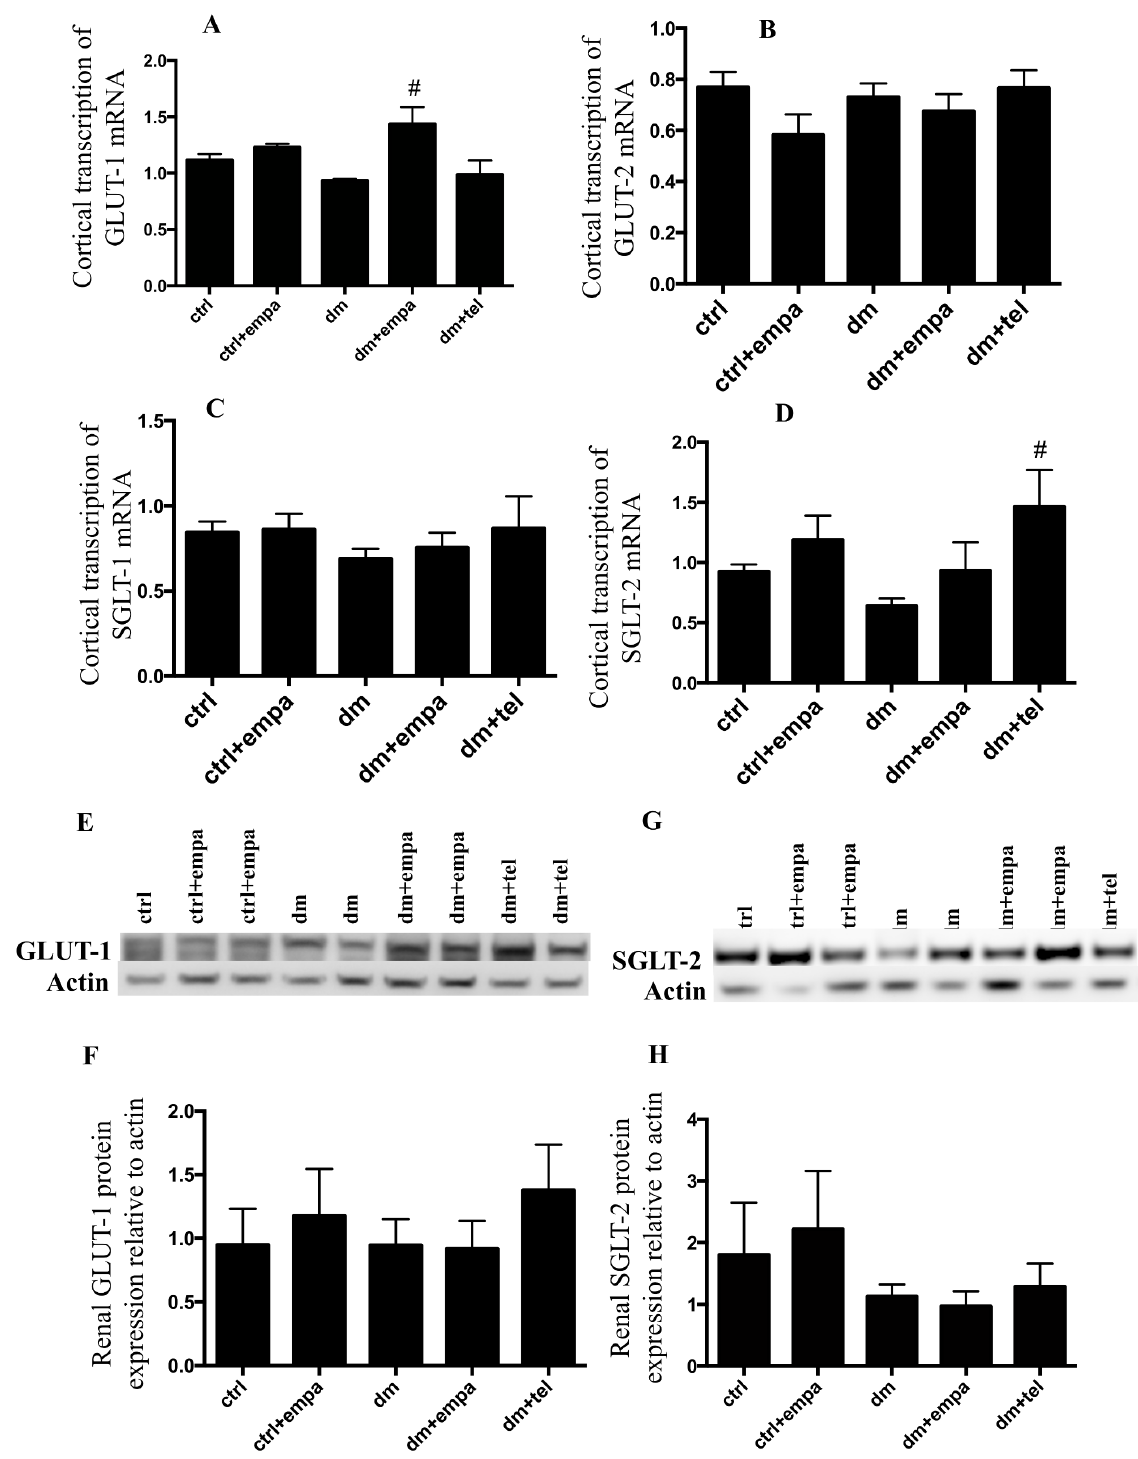
Figure 6. Empagliflozin increased renal GLUT1 transcription in comparison with untreated diabetic mice although renal protein expression of GLUT1 and SGLT2 were unchanged. Real time PCR results for A) GLUT1, B) GLUT2, C) SGLT1 and D) SGLT2 expressed relative to actin. Expression levels of renal GLUT1 protein (E and F) and SGLT2 (G and H) relative to actin (Data are expressed as mean 6 SEM with # =P , 0.05 vs dm).